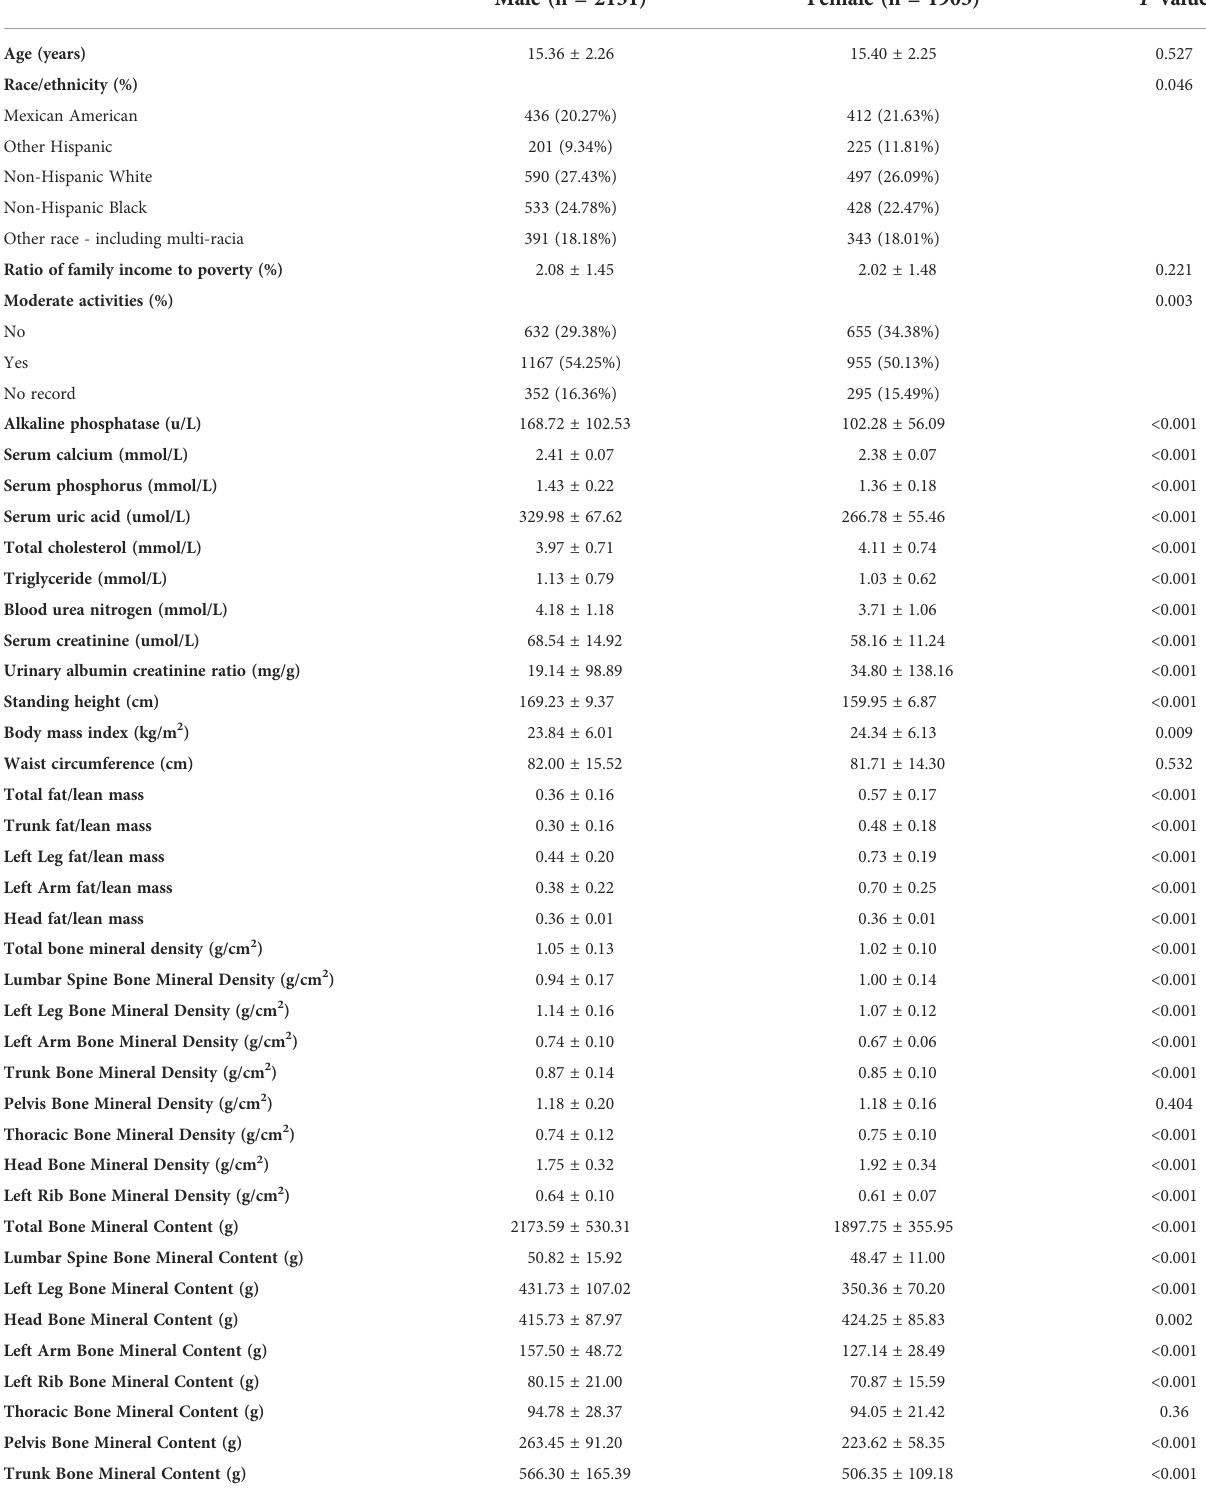
TABLE 1 Weighted characteristics of the study